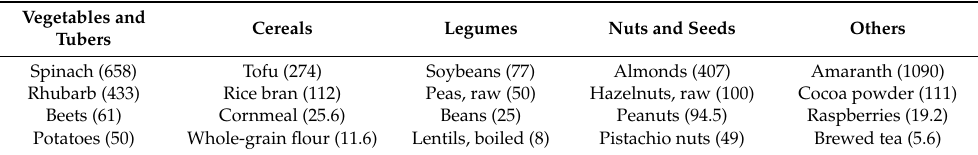
Table 1. Higher oxalate foods (mg of oxalate per 100 g